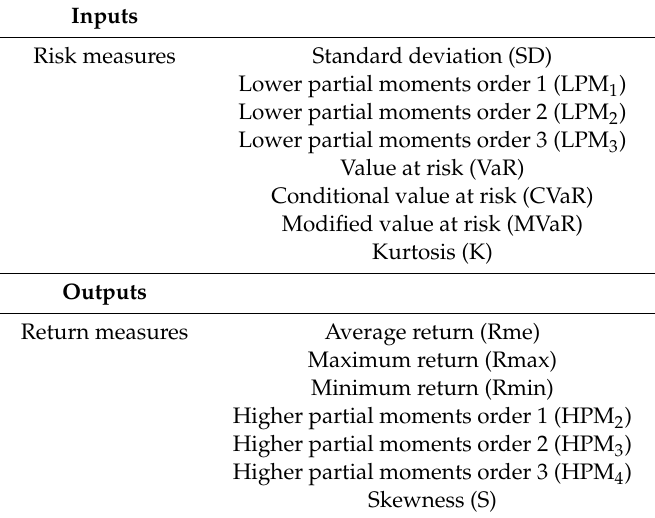
Table 2. Potential inputs and outputs in data envelopment analysis (DEA) 1